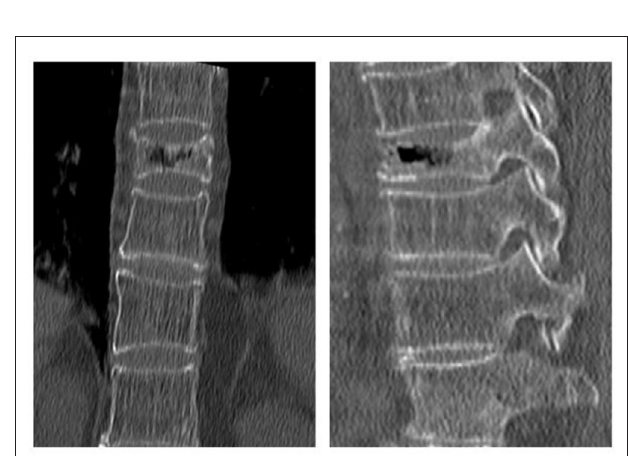
FIGURE 3 | Intravertebral vacuum cleft (IVC) was demonstrated by computed tomography at L1 level.